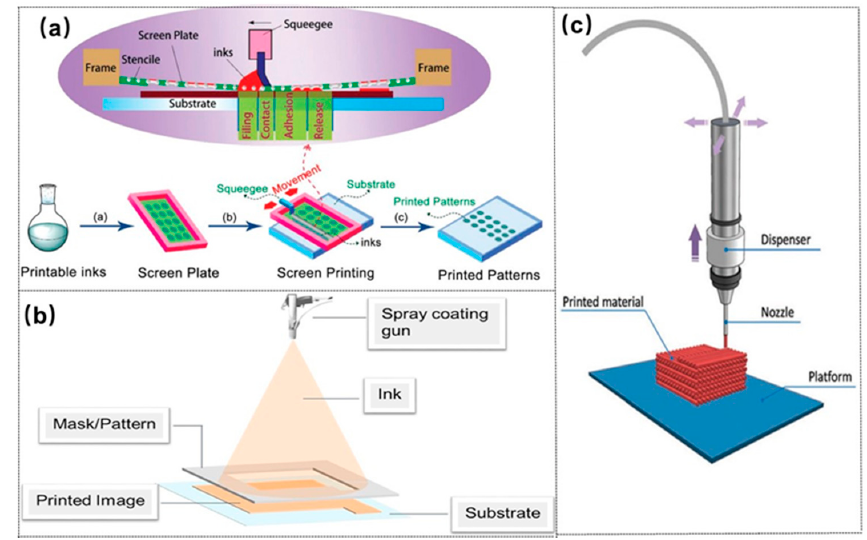
Figure 15. Schematics of ( a ) a screen printing [71] (Copyright © 2017, RSC Pub), ( b ) spray printing [72] (Copyright © 2015, John Wiley and Sons), (c) direct ink writing processes [73] (Copyright © 2017, John Wiley and Sons).